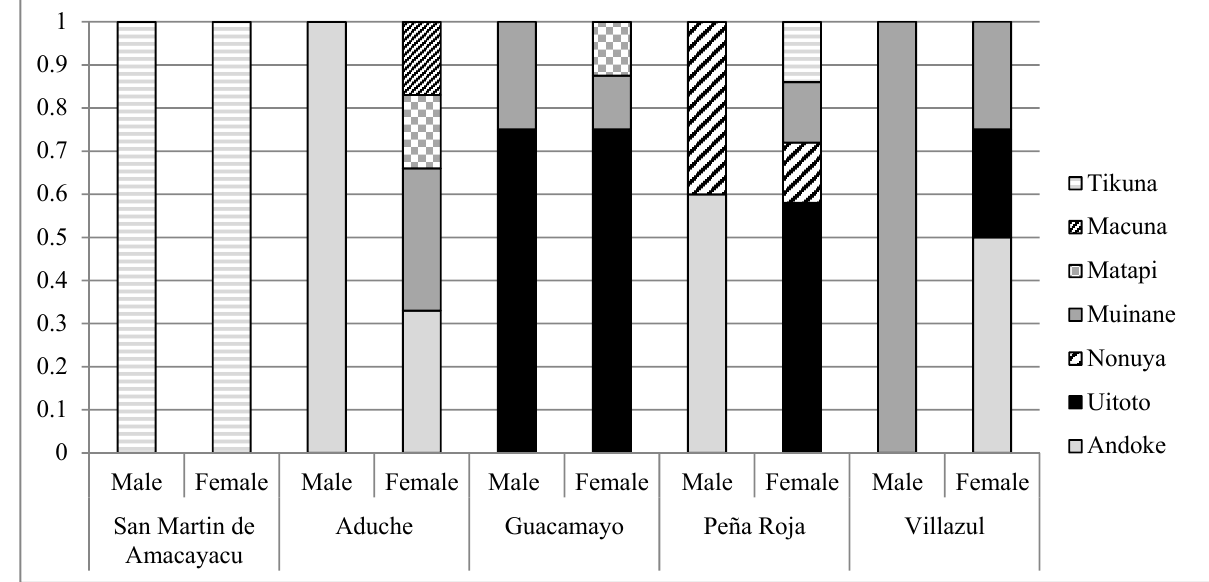
Figure 5. Ethnic composition (in fractions) of the group of family farmers in each community who participated in this